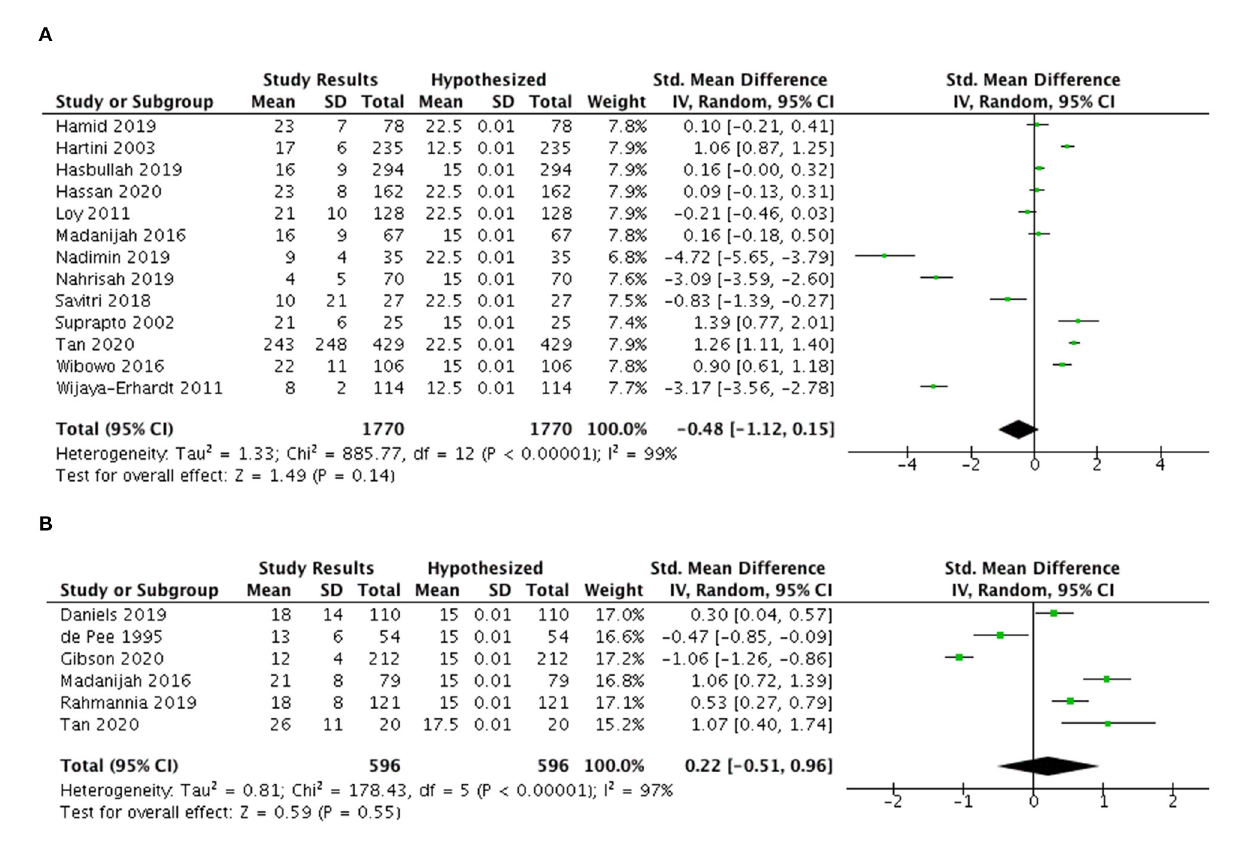
mothers were in a “cold state” after delivery. Restriction of consuming certain types of foods was believed to balance the hot and cold states of the body (29,